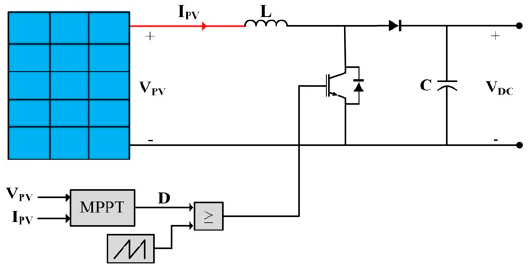
Figure 3. Overall control structure of the PV system.